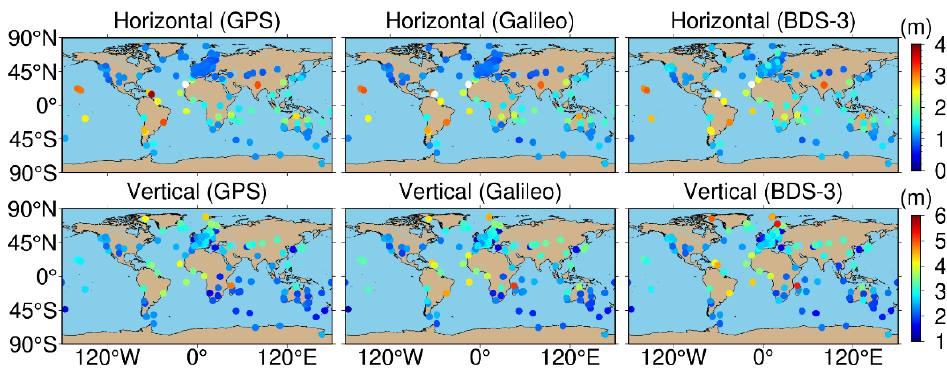
Figure 7. Boxplot of position accuracy of single-frequency SPP with an elevation cut-off of 7° for GPS, Galileo, and BDS-3.